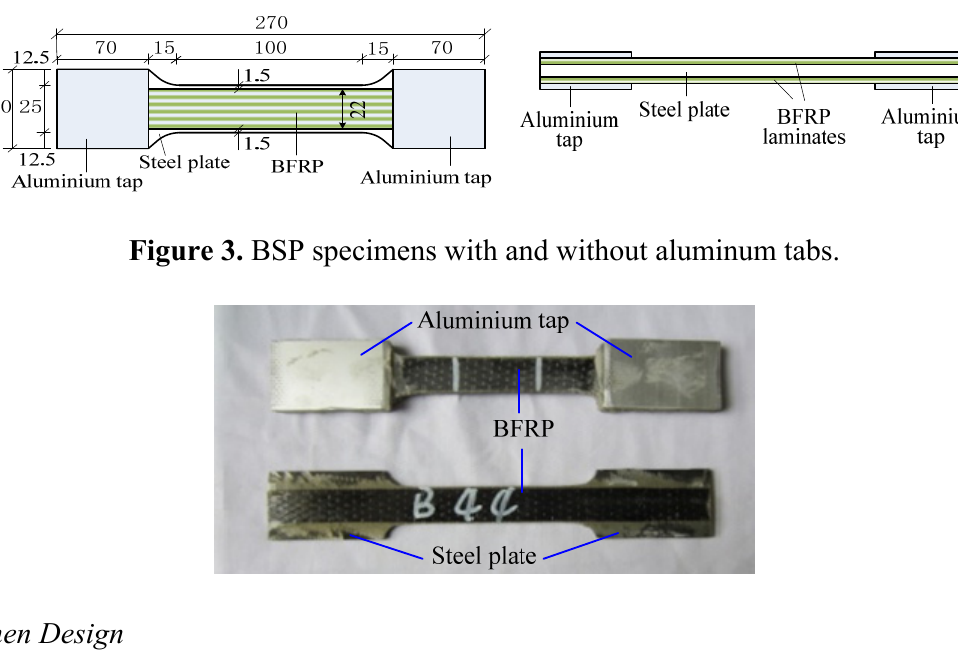
Figure 2. Diagram of the BSP specimen (units in mm).